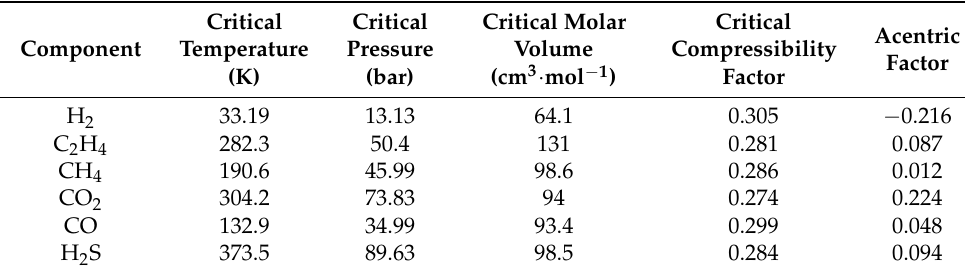
Table 7. Thermodynamic properties of gas mixture components produced during the steam gasifica- tion of HO1 and HO2 with and without nanoparticles. Critical Critical Critical Molar Critical Component Temperature Pressure Volume Compressibility (K) (bar) (cm 3 · mol − 1 ) H 2